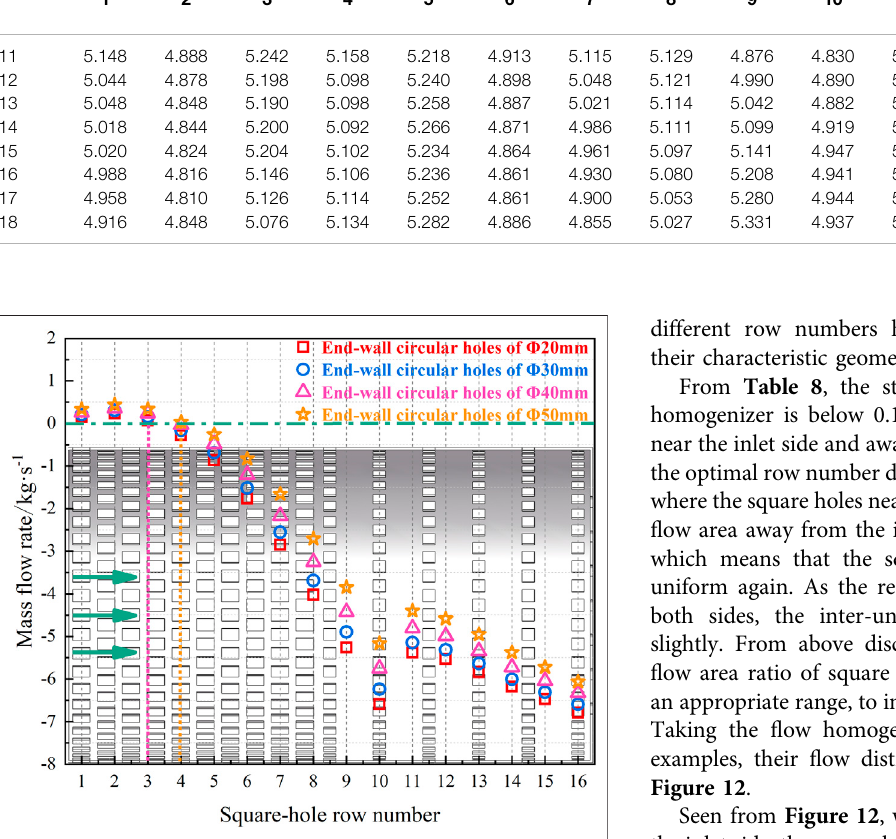
TABLE 6 | Numerical results of inter-unit fl ow rate distribution for fl ow homogenizers with different end-wall circular hole diameters. Case No.